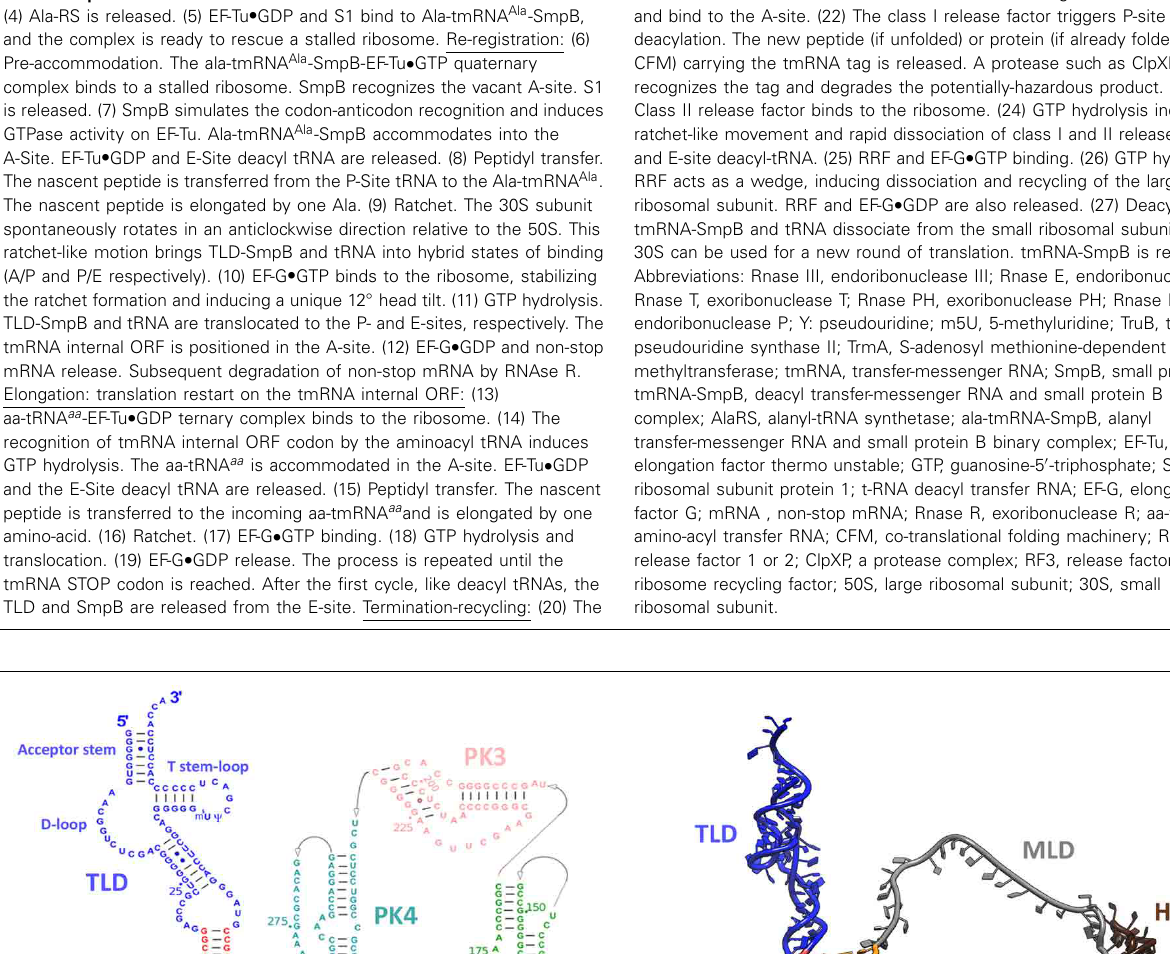
pink; and pseudoknot 4 (PK4) is teal. The codons are underlined and shown in a larger font. The resume codon is yellow and the stop codon is indicated.